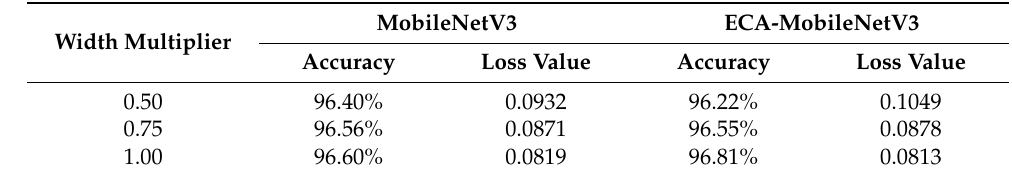
Table 5. Comparison table of accuracy and loss values for different width multipliers on Beijing– Tianjin–Hebei airport cluster dataset.